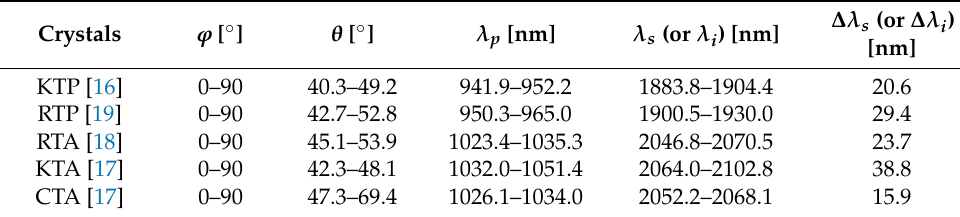
Figure 4. Effective nonlinear optic coefficients ( d eff ) calculated numerically under Type II EPM: ( a ) KTP and RTP; ( b ) RTA, KTA, and CTA.